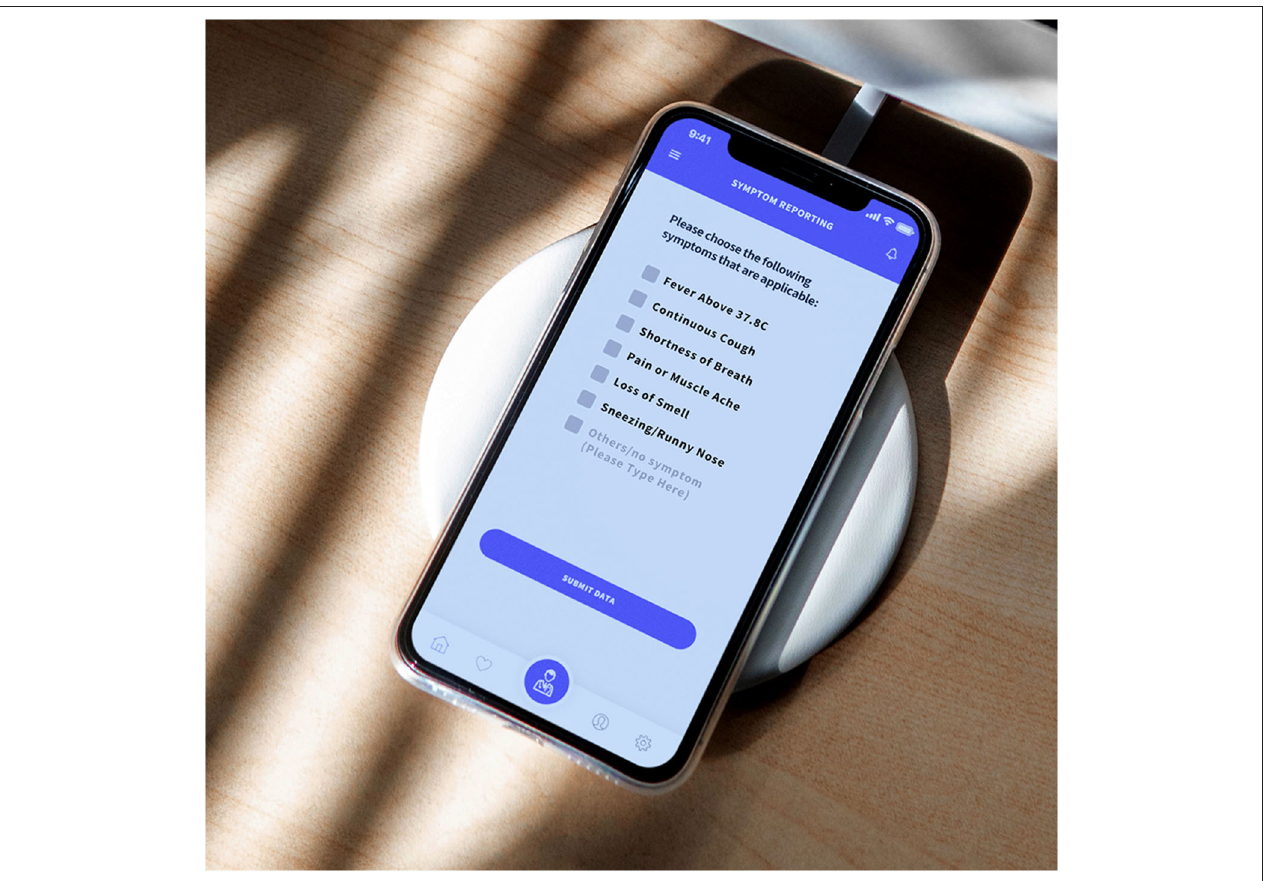
FIGURE 10 | Symptom reporting page, with the most common options for COVID-19. The entries eventually form tagged-dataset for the